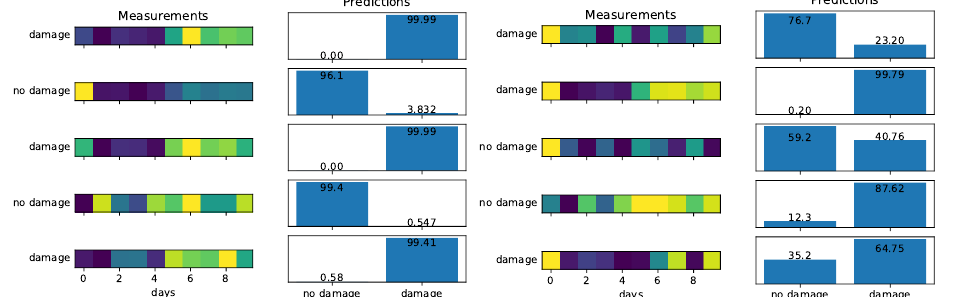
Figure 8. Performance of the proposed neural network using a single natural mode. On the left, the degradation coefficient is 0.5 (severe damage easy to be identified), and on the right, the degradation coefficient is 0.8 (limited damage that is hard to be